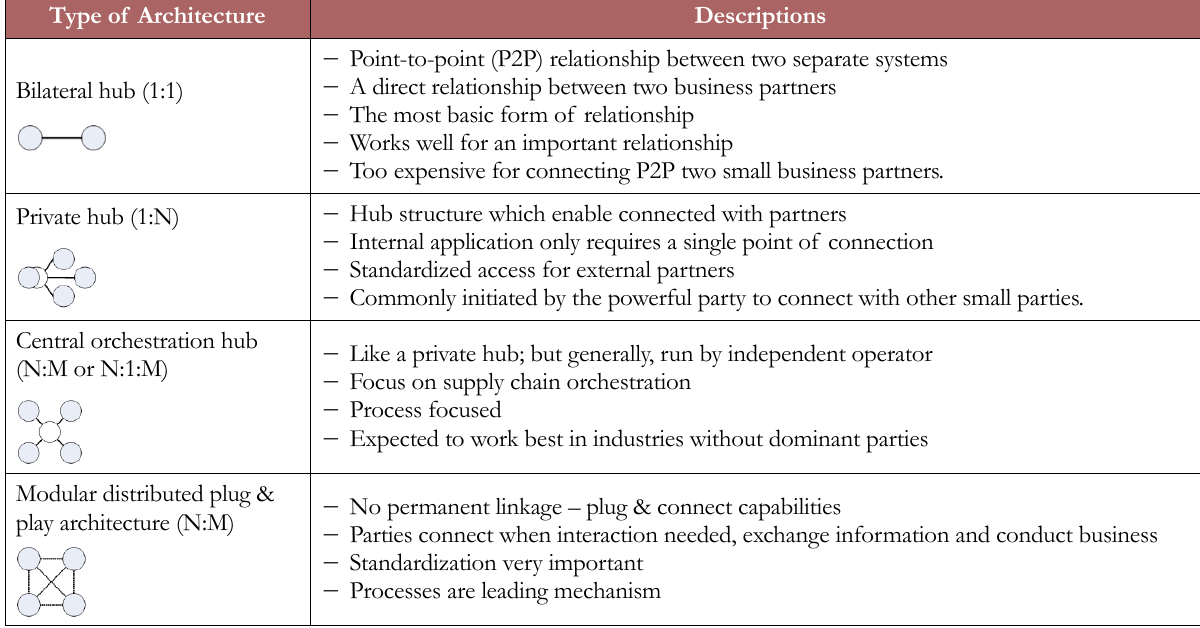
Table 1. Type of IOS